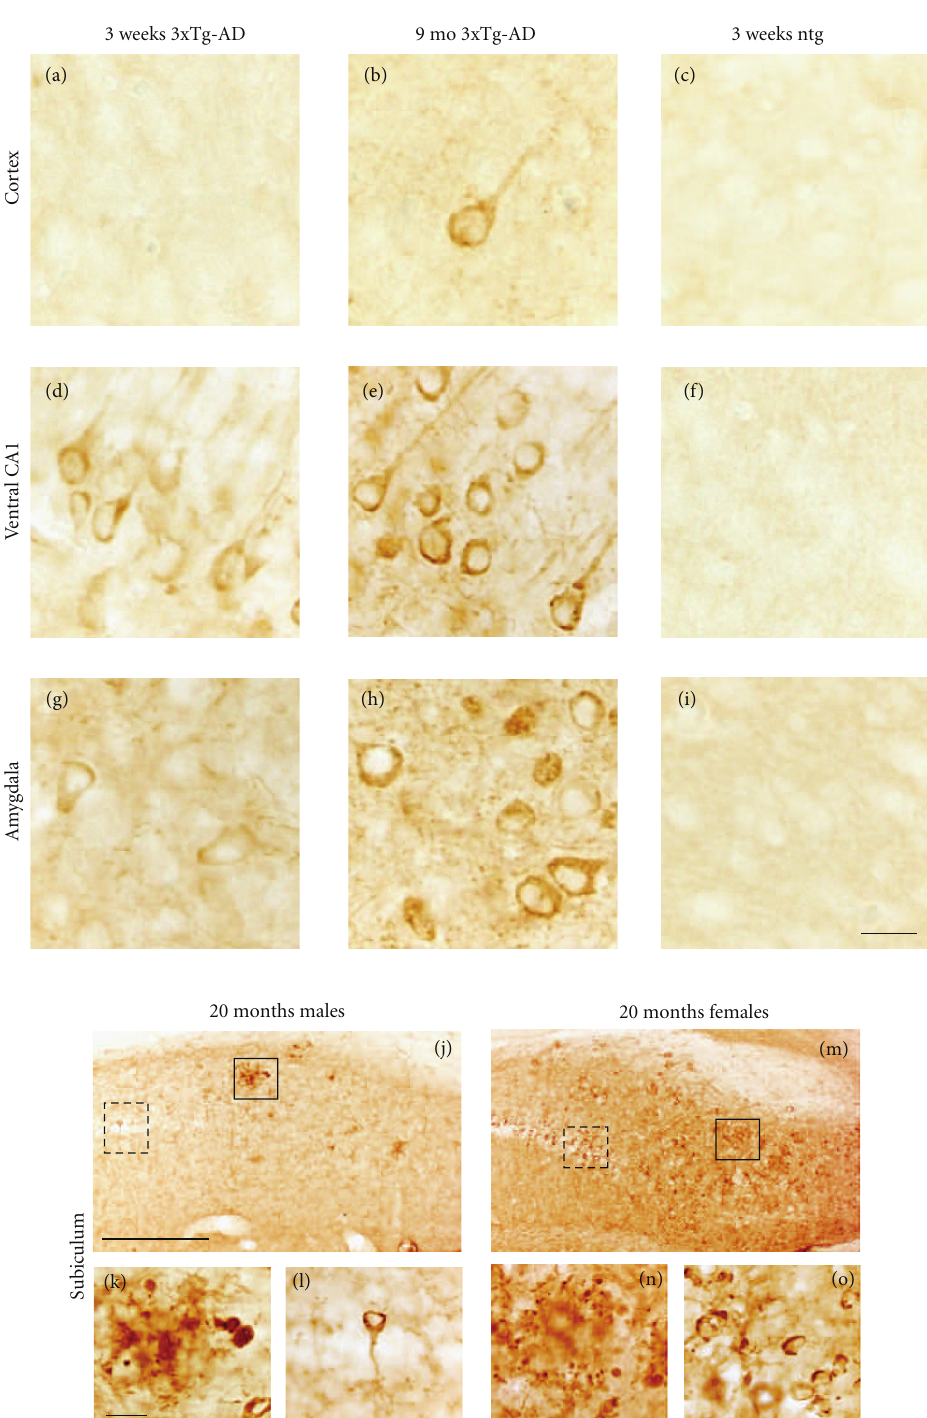
Figure 10: Photomicrographs showing PHF-1 immunostaining in cortex ((a)–(c)), hippocampus ((d)–(f)), BLA ((g)–(i)), and subiculum ((j)–(o)) in 3xTg-AD mice. PHF-1 immunostaining was seen almost exclusively in the ventral hippocampus of perfusion-fixed brains (d) compared to the cortex (a) and the BLA (g) at 3 weeks of age. By 8-9 months, many more PHF-1-ir neurons were apparent in the hippocampus and BLA ((e), (h)). Only scattered PHF-1-ir neurons were found in the neocortex at this age (b). Many more PHF-1 immunopositive neurons appeared in the dorsal anterior CA1 region of female mutant mice (area outline by dashed line in M and shown at higher magnification (o)) compared to males (area outline by dashed line in (j) and shown at higher magnification in (l)) at 18–20 months of age. PHF-1 immunopositive plaques were seen in the subiculum of male (solid boxed area in (j) and (k)) and female (solid boxed area in (m) and (o)) 3xTg-AD mice at 18–20 months of age. Note that the extent of PHF-1 immunoreactivity was greater in the subiculum in females (M) versus males (J). PHF-1-ir profiles were absent in ntg mice ((c), (f), (i)). Scale bars: (a)–(i); ((k), (l), (n), (o)) = 20 μ m and ((j), (m)) = 100 μ